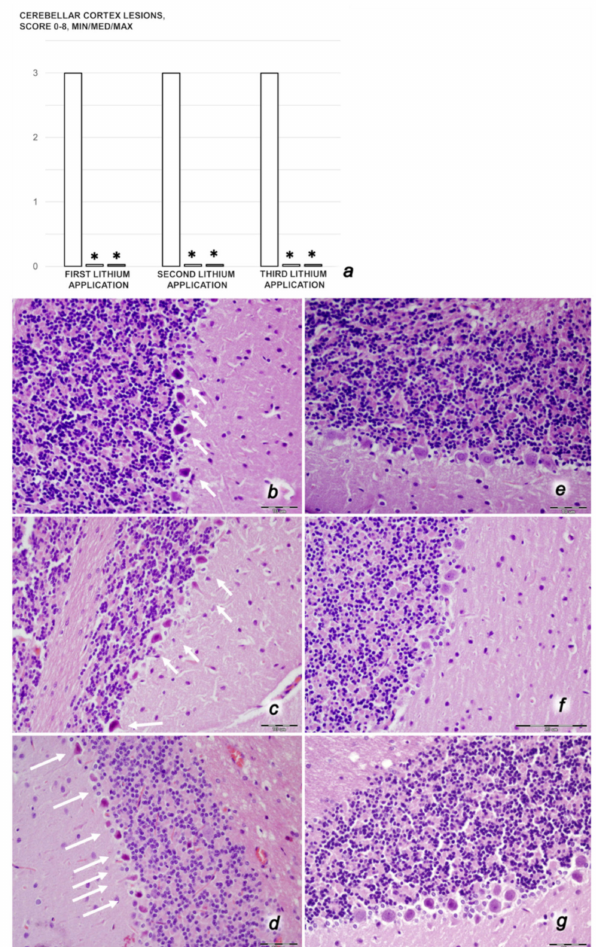
Figure 15. Brain pathology. Neuropathological changes of the cerebellar cortex. ( a ) Semiquantitative neuropathological scoring system analysis of lesions of the cerebellar cortex in the lithium rats after the first, second, and third lithium administration (500 mg/kg/day intraperitoneally for 3 consecutive days). BPC 157 10 µ g/kg (light gray bars), 10 ng/kg (dark gray bars); saline 5 mL/kg (white bars) given intraperitoneally after each of the three lithium administrations. Six rats/group/interval. Min/Med/Max, * p < 0.05, at least vs. control. In control rats the increased rate of cerebellar cortex area occurred to grade 3 (up to 75 percent of cerebellar cortex area affected with more extensive karyopyknotic areas) after each lithium administration, whereas in BPC 157-treated rats no neuronal changes were found. Cerebellar cortex histology ( b – g ). Control ( b – d ), BPC 157 ( e , f ); first lithium application ( b , e ), second lithium application ( c , f ), third lithium application ( d , g ). A marked karyopyknosis, degeneration (arrows), and loss of Purkinje cells of the cerebellar cortex, persistent congestion, and cerebellar edema presented in the control lithium-treated rats after each of the lithium administrations. In contrast, BPC 157-treated rats showed a normal structure of the cerebellar cortex (HE; magnification × 400, scale bar 10 µ